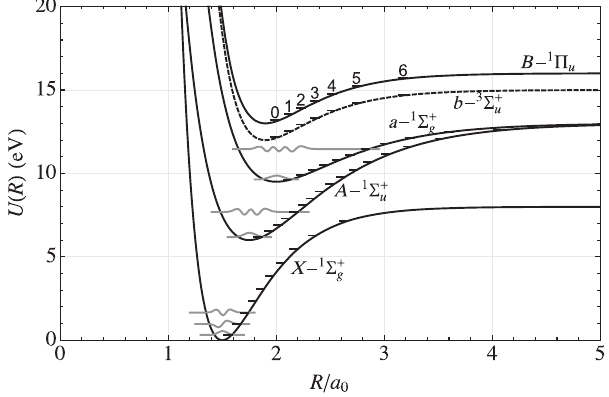
FIG. 3. Electronic potential energy U ð R Þ curves for a (hypo- thetical) homonuclear diatomic molecule as a function of internuclear separation R for five different electronic states, labeled by their quantum numbers, X - 1 Σ þ , A - 1 Σ þ , a - 1 Σ þ , g u g b - 3 Σ þ , and B - 1 Π , respectively. Ticks in the potential well of u u each curve indicate vibrational energy levels, e.g., labeled from v ¼ 0 ; … ; 6 in the fourth excited electronic state B - 1 Π . Exem- u R Þ are plotted in gray (with plary vibrational wave functions ψ v ð arbitrary vertical units) for a few vibrational states, including the lowest three of the ground electronic state. Rotational energy splittings are not shown. The ground state X - 1 Σ þ can be excited to g by a monopole operator, and to A - 1 Σ þ the first excited state a - 1 Σ þ g u and B - 1 Π by a dipole operator. A spin-dipole operator can also u cause transitions to the spin-triplet state b - 3 Σ þ , in addition to u those caused by a regular dipole